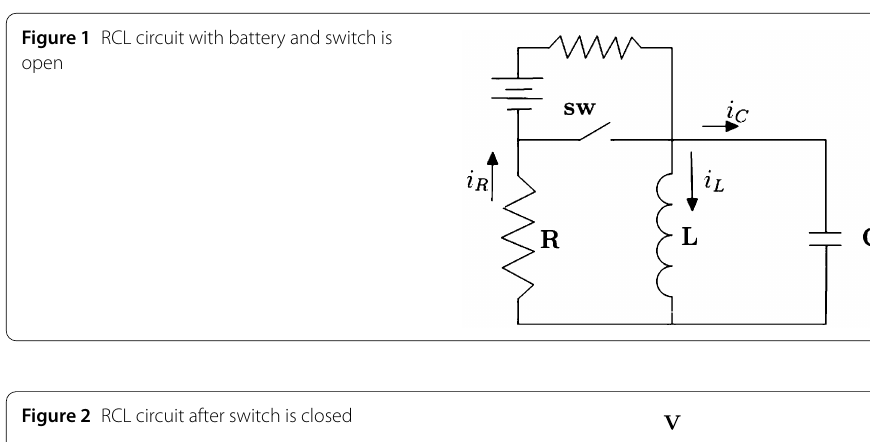
Figure 2 RCL circuit after switch is